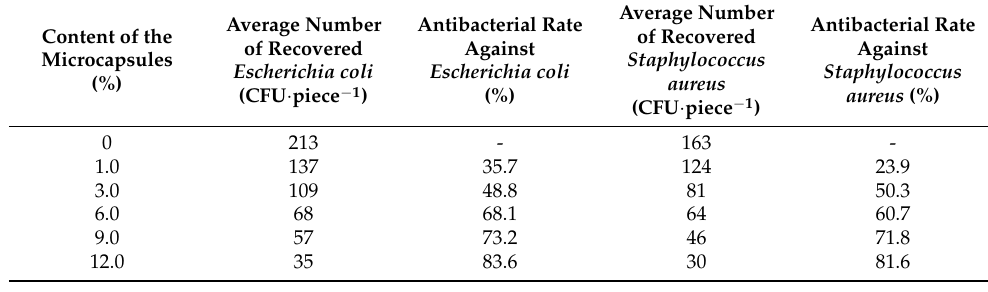
Table 12. Antibacterial rates of the paint films with different loadings of the microcapsules.